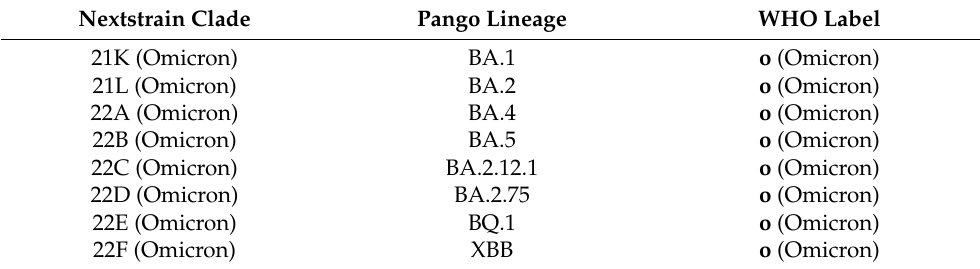
Table 1. Nextstrain clade, Pango lineage and WHO labels of the investigate lineages showed in Figure 1. Nextstrain Clade